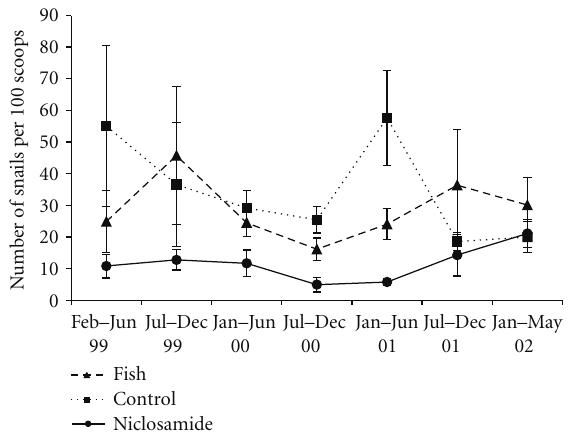
Figure 5: Average number of snails collected from night storage ponds from February 1999 to May 2002